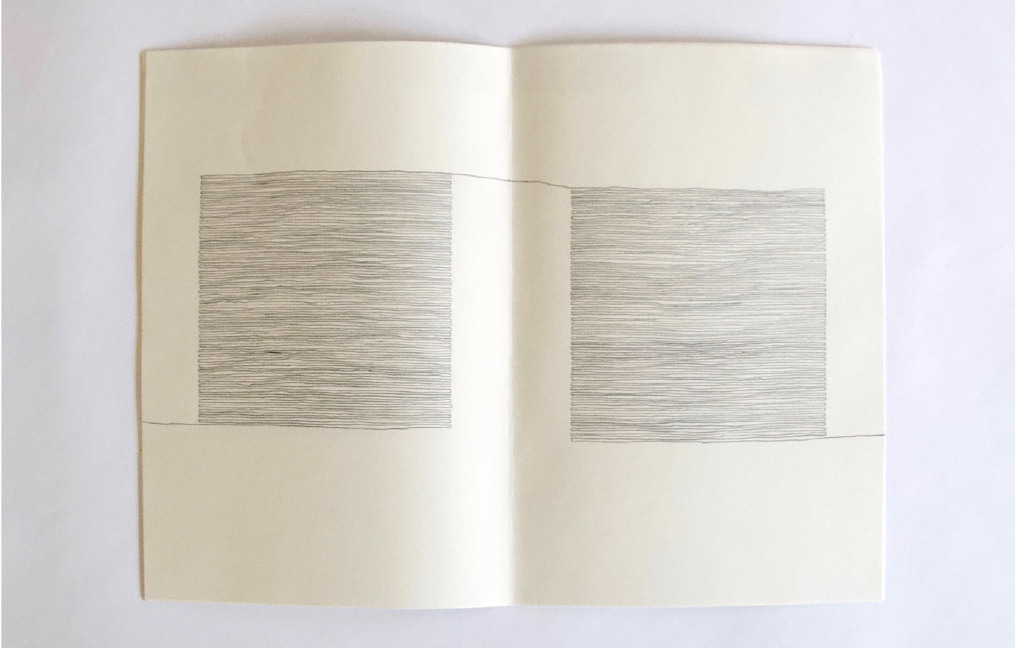
Figure 11. A line that, in theory, could connect us , 2019. Studio experiment detail. Pencil on paper. Collection of the artist.